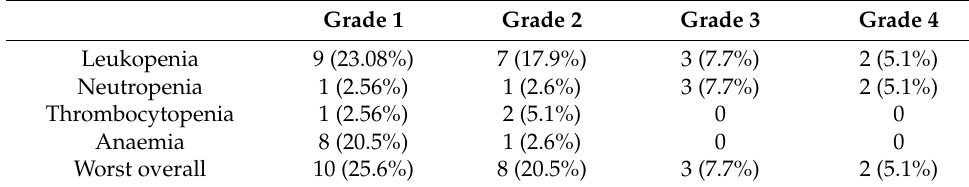
Table 3. Acute haematologic toxicity (CTCAE version